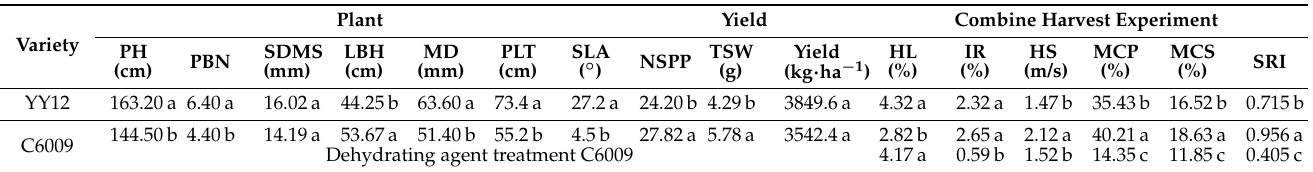
Table 2. Field combine harvest comparison test of screened variety C6009 and control variety YY12 in 2020 in Yangzhou. Different lowercase letters in a column correspond to significantly different values at the level of 0.05.